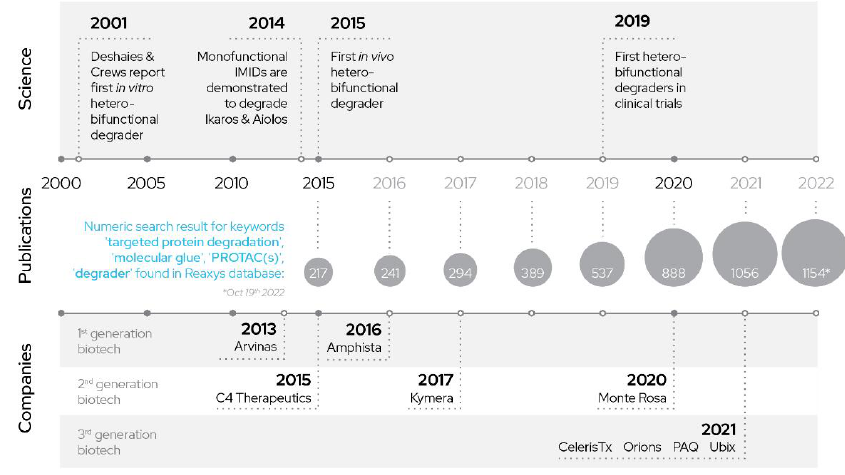
Figure 2. History of PROTACs: development of PROTACs over years.